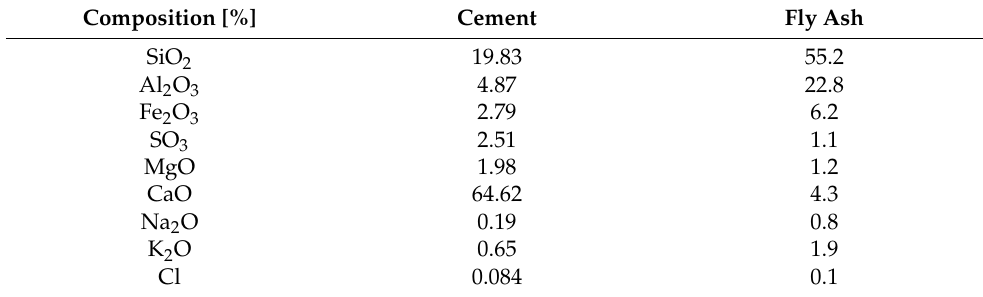
Table 1. Chemical compositions of cement and fly